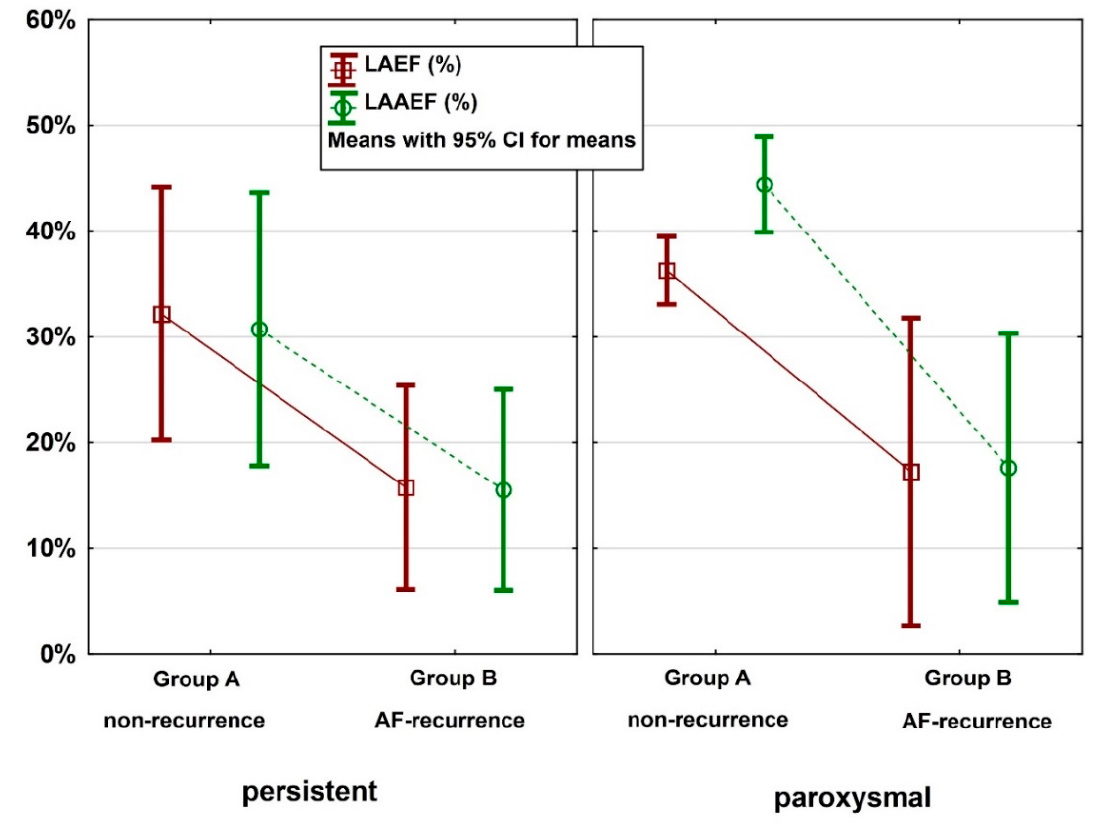
Figure 3. Box-plots of LAEF and left atrial appendage ejection fraction (LAAEF) (%) for non-recurrence (group A) vs. AF Figure 3. Box ‐ plots of LAEF and left atrial appendage ejection fraction (LAAEF) (%) for non ‐ recur ‐ recurrence (group B), separated into the subgroups paroxysmal and persistent rence (group A) vs. AF recurrence (group B), separated into the subgroups paroxysmal and persis ‐ tent AF.